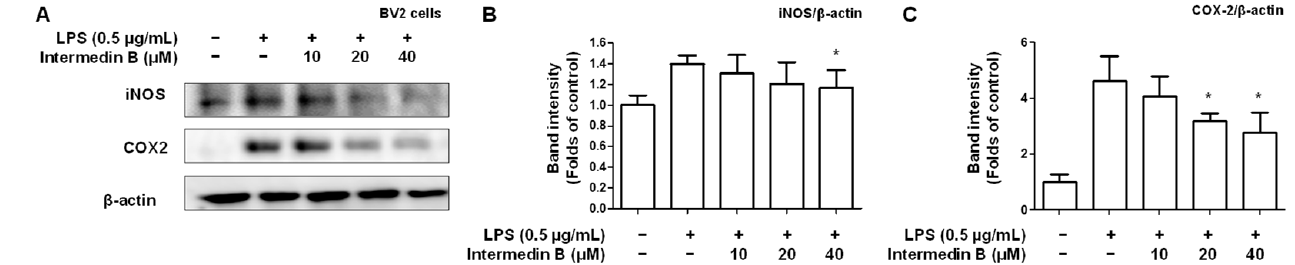
Figure 7. Effect of intermedin B ( 4 ) isolated from C. longa on inhibiting iNOS and COX-2 expression in LPS-induced BV2 microglia. To examine the inhibitory effect of intermedin B ( 4 ) on the expression of pro-inflammatory proteins iNOS and COX-2, cells were treated with LPS for 18 h following pretreatment with 10–40 µ M of intermedin B ( 4 ). ( A ) Western blotting was performed, and the immunoblot was quantified using ImageJ software to quantify the expression levels of iNOS ( B ) and COX-2 ( C ). The intensities of the bands were normalized to those of β -actin, and the data are presented as the mean ± SD values of 3 independent experiments. * p < 0.05 compared with LPS. We investigated whether intermedin B ( 4 ) was involved in regulating NF- κ B in LPS- induced BV2 microglia. To investigate whether intermedin B ( 4 ) was involved in NF- κ B control, cytosolic and nuclear extracts were extracted from LPS-induced BV2 microglia. As a result, intermedin B ( 4 ) was inhibited by the nuclear factor degradation of the kappa light polypeptide gene enhancer and nuclear translocation of p-I κ B α and p65 in a concentration- dependent manner (Figure 8).